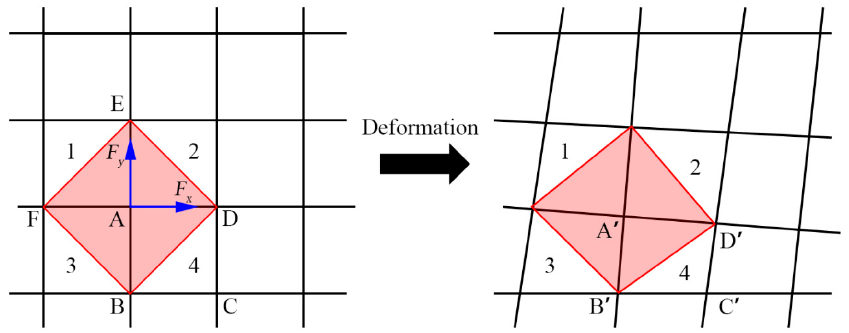
Figure 8. Elements and potential deformation under dynamic loading.